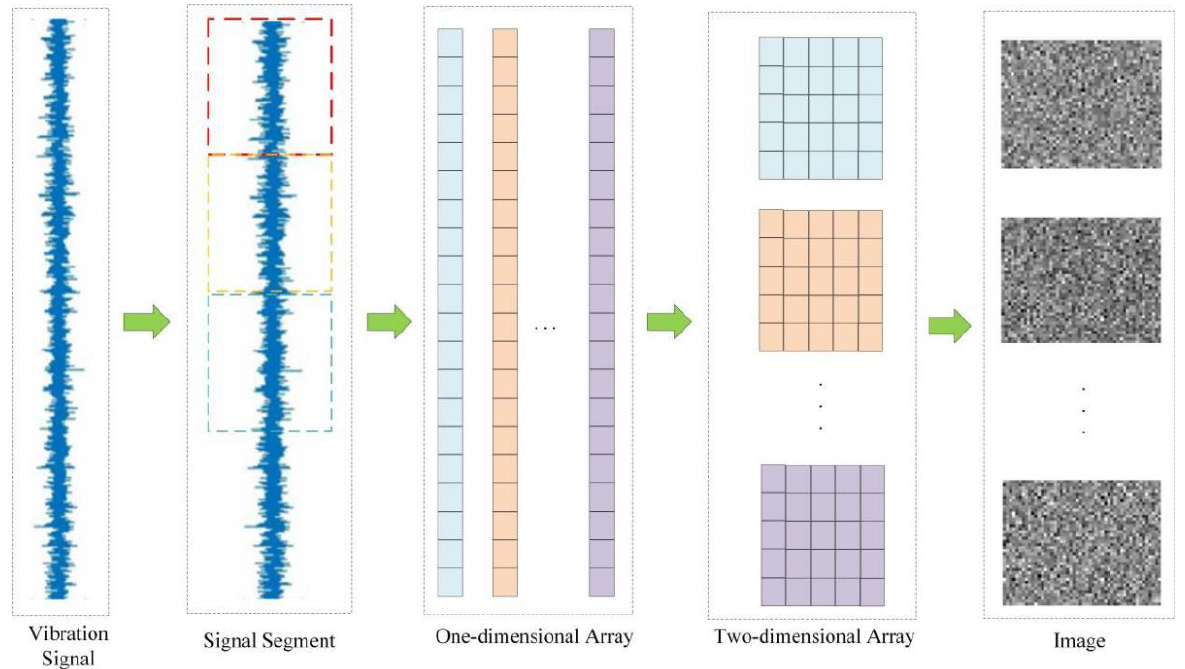
Figure 6. Data processing flow chart.